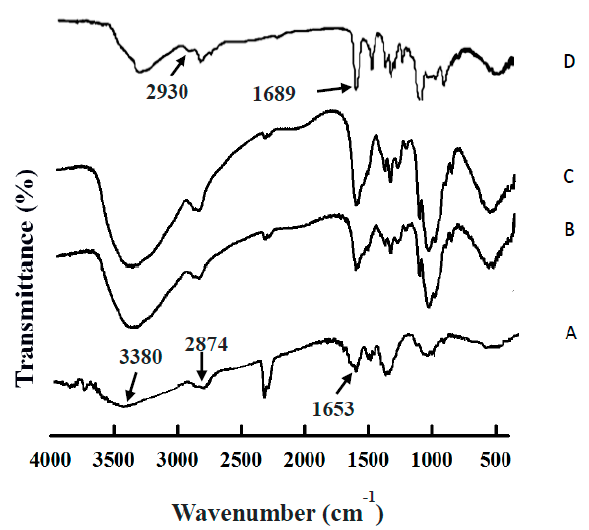
Figure 5. FTIR spectra of the ( A ) chitosan particles, ( B ) SPIO NPs–chitosan composite particles (chitosan MW, 150,000), ( C ) SPIO NPs–chitosan composite particles (chitosan MW, 40,000), and ( D ) VBL-loaded SPIO NPs–chitosan composite particles (chitosan MW, 150,000).